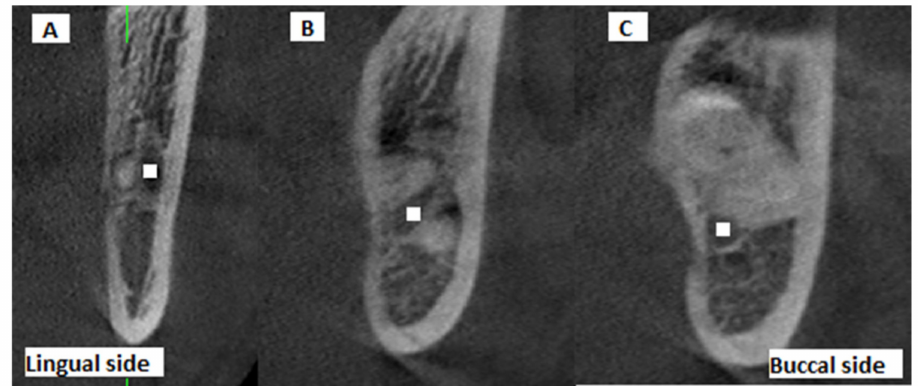
Figure 2. Cropped panoramic radiographs showing the ( A ) interference with the white line and ( B ) darkening of roots.